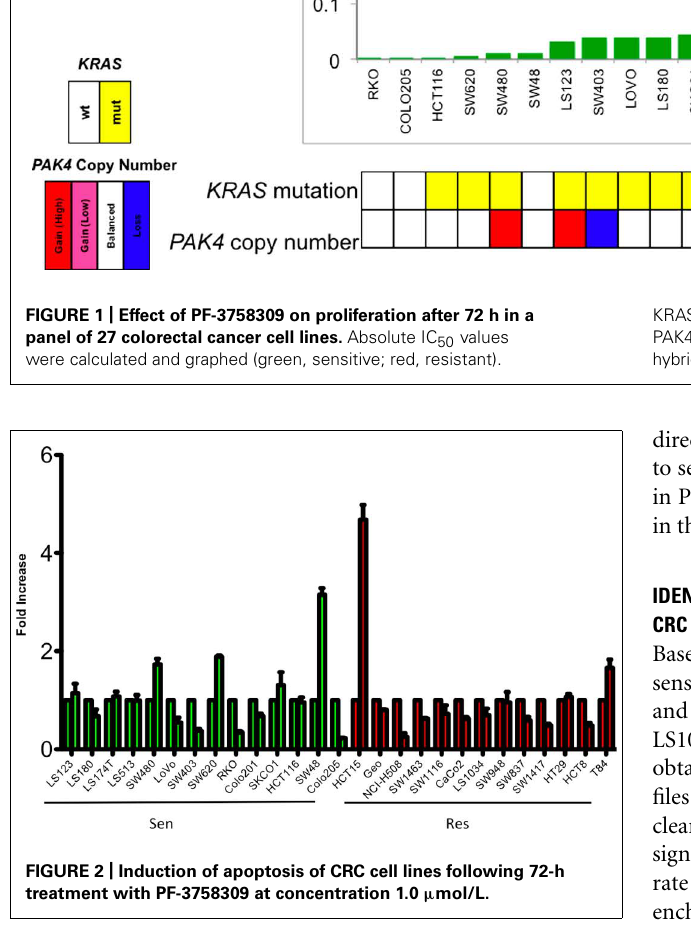
However, when comparing the sensitive versus resistant CRC cell lines, we observed that β -catenin, AMPK α 1, and AKT (S473) were all suppressed in the sensitive lines following exposure to